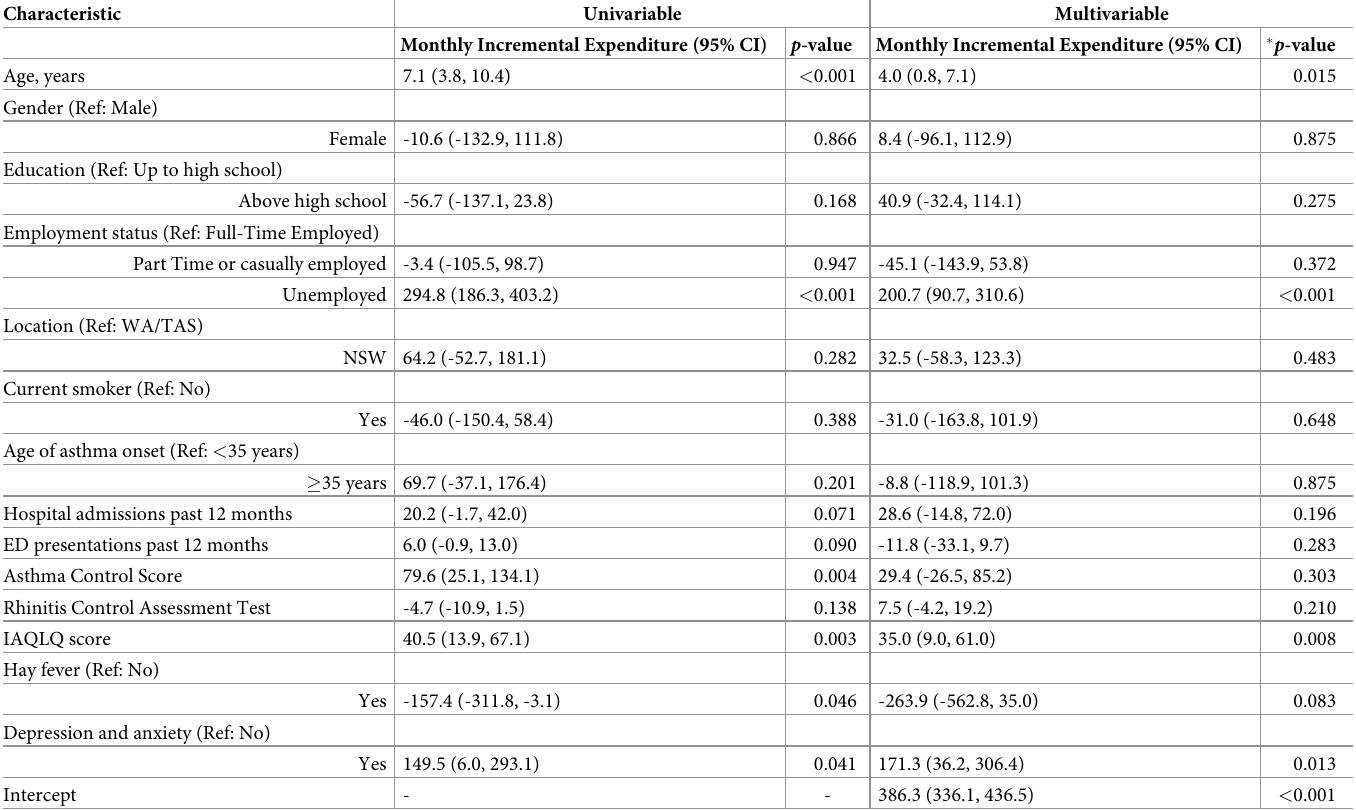
Table 2. Predicted increase in monthly expenditure associated with a range of baseline characteristics in participants with poorly controlled asthma ($AU).